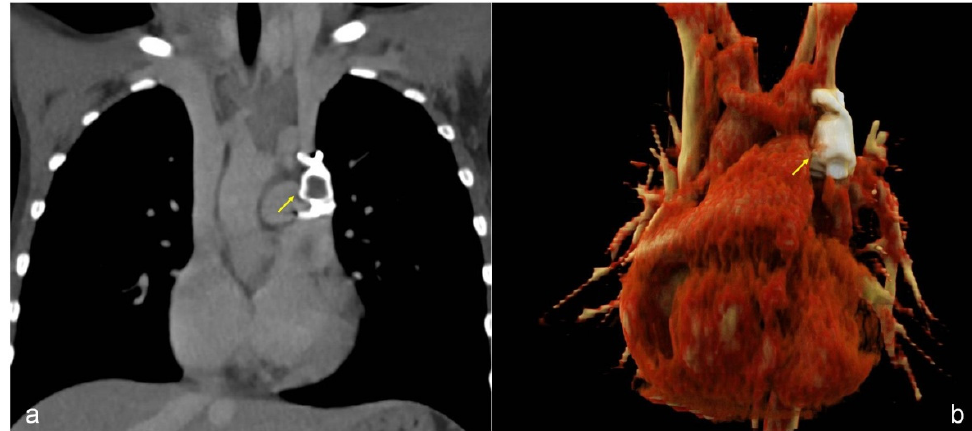
Figure 2. ( a ). Computed tomography two months after occlusive device insertion (arrow). ( b ). A 3D-volume rendering image shows proper position of the plug and confirms left SVC occlusion. Blood reaches the right SVC through the bridging vein; its current diameter is 9